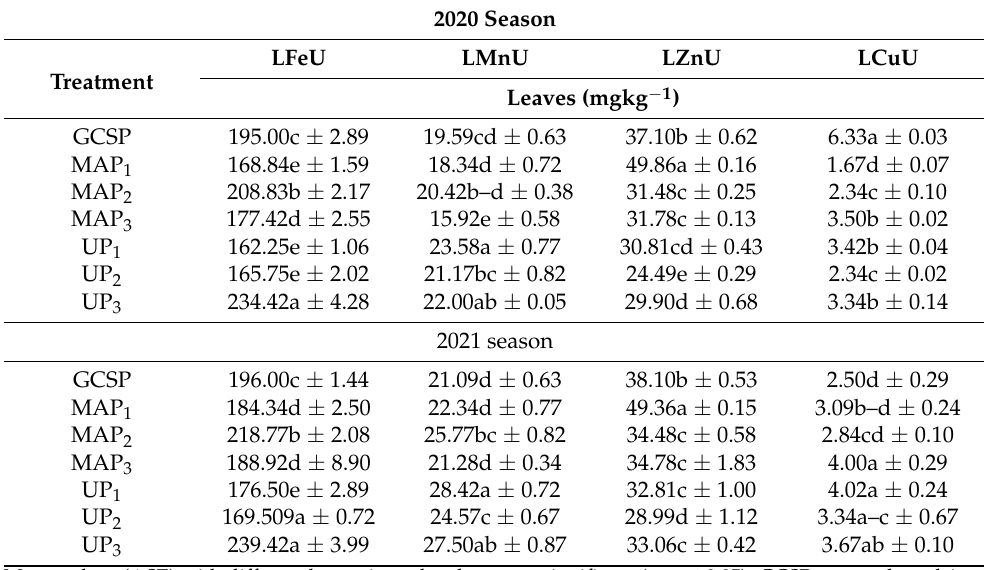
Mean values ( ± SE) with different letters in each column are significant (at p ≤ 0.05). GCSP = granular calcium super phosphate, MAP = mono-ammonium phosphate, UP = urea phosphate, MAP 1 , MAP 2 , and MAP 3 represent